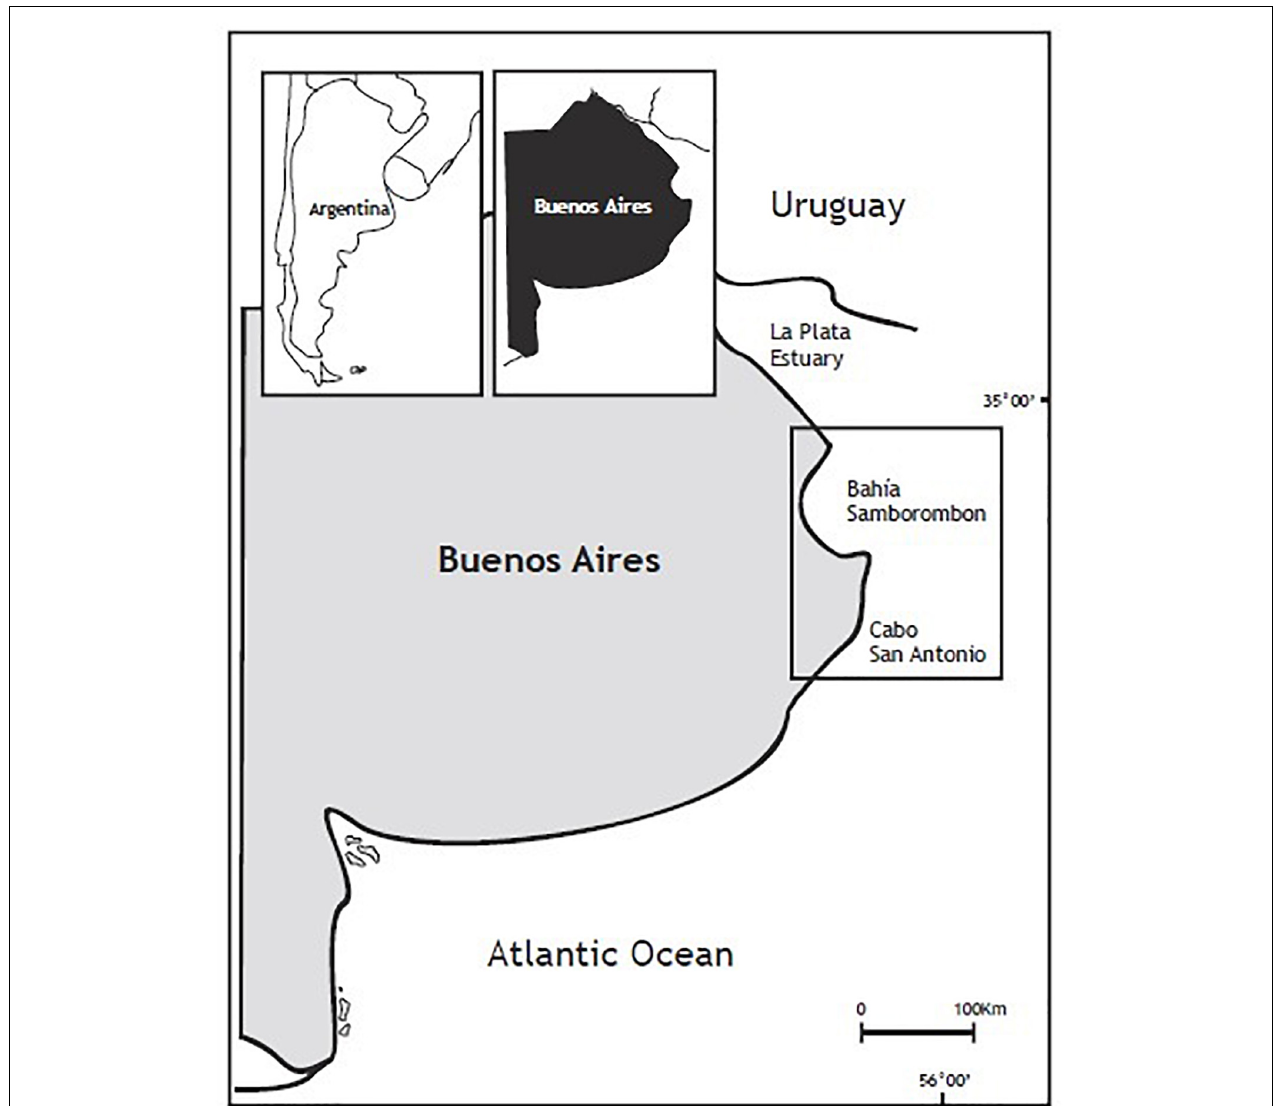
FIGURE 1 | Location of the study areas, Bahía Samborombón (BSB) and Cabo San Antonio